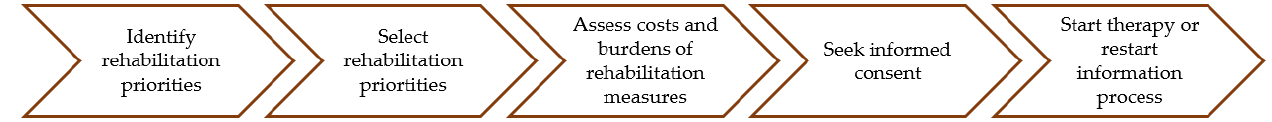
Figure 5. Process from identification, selection, cost and burden assessment, to seeking informed consent and starting the rehabilitation process.